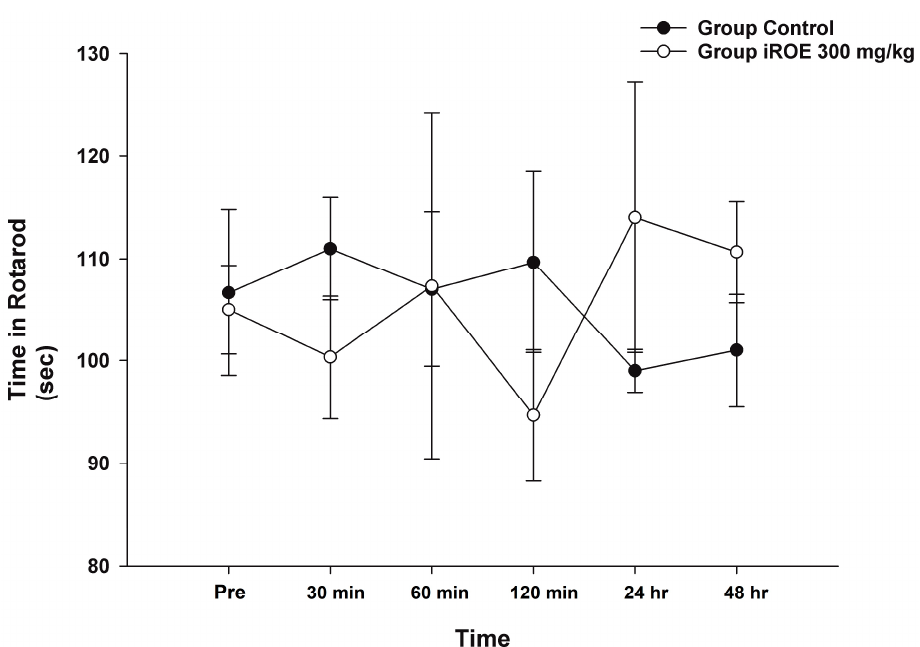
Figure 6. Effect of immature R. occidentalis on Rotarod testing. iROE, immature Rubus occidentalis extract.